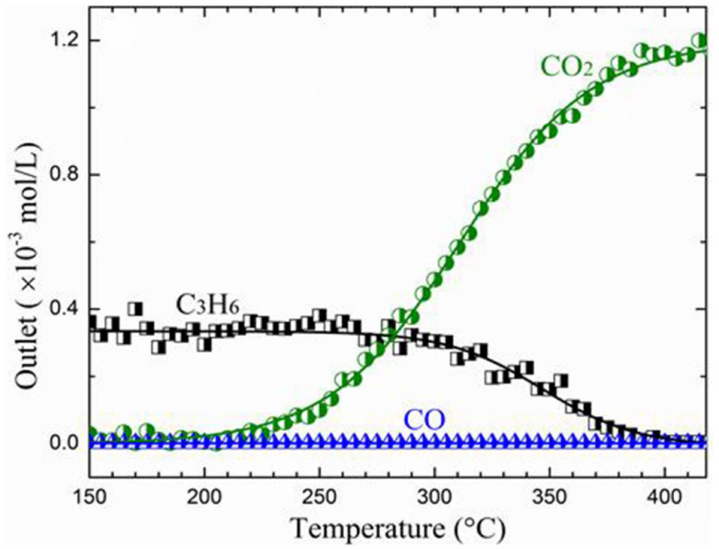
Figure 10. Light-off curves of C 3 H 6 conversion over the most Cu loaded catalyst (reproduced from Ref. [206]).